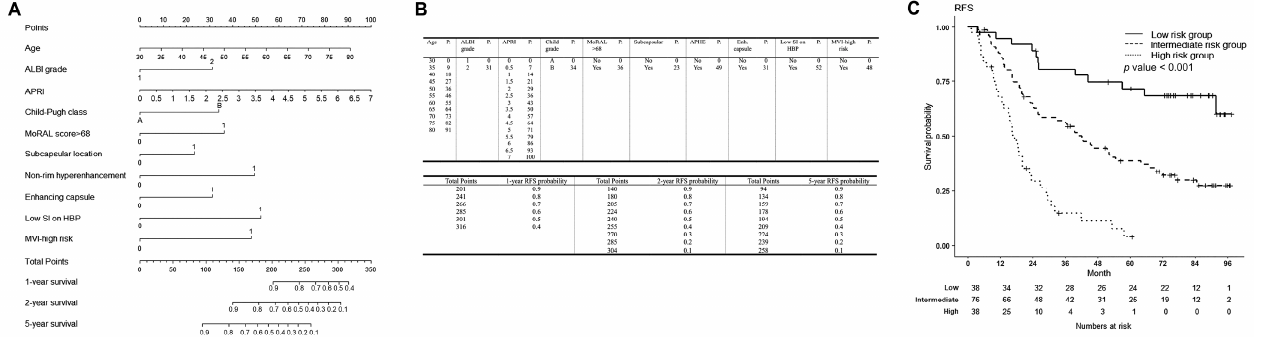
Figure 2. Nomogram to estimate recurrence-free survival (RFS) after percutaneous radiofrequency ablation for HCC, and nomogram-based low-, intermediate- and high-risk groups for RFS. ( A ) The included variables in the nomogram for RFS are age, Albumin-Bilirubin grade 2 (reference: grade 1), aspartate aminotransferase/platelet ratio index, Child-Pugh classification B (reference A), MoRAL score > 68, subcapsular location, non-rim hyperenhancement of the lesion (reference: no enhancement), enhancing capsule (reference: no enhancing capsule), low signal intensity (SI) of the lesion on hepatobiliary phase on gadoxetic acid-enhanced liver MRI (reference: iso or high SI), and microvascular invasion-high risk group. ( B ) The prognostic points of each variable are shown in the upper table, and the estimated RFS rate at 1, 2, and 5 years after RFS for HCC according to the total points are shown in the lower table. ( C ) For RFS, patients with nomogram scores in the lower quartile (<25%, 185.75 points) were classified as low-risk, those in the upper quartile (>25%, 242.56 points) as high-risk, and those in between (25–75%) were classified as intermediate-risk groups. The RFS rates of the low, intermediate, and high risk groups were 94.6% (95% CI 87.6–100%), 86.7% (95%